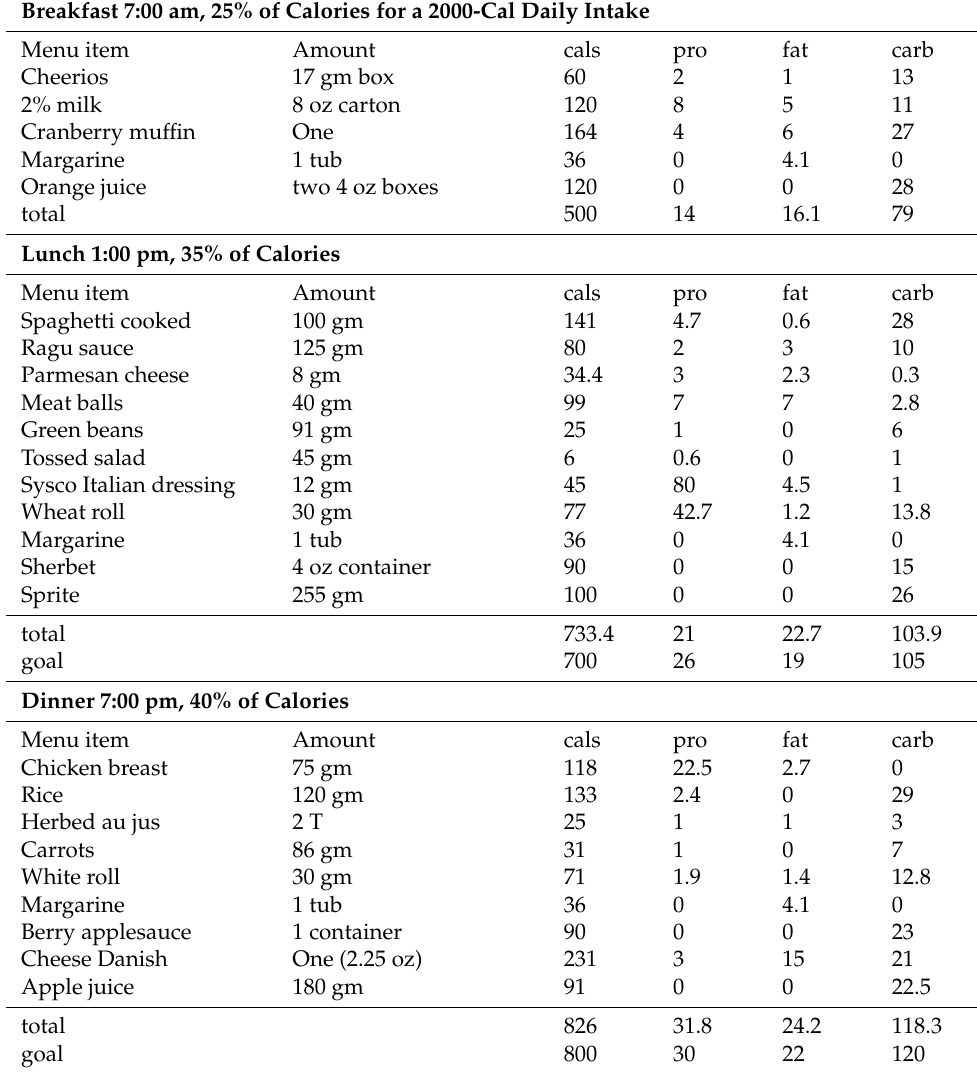
Table 1. Composition of the three meals provided to study